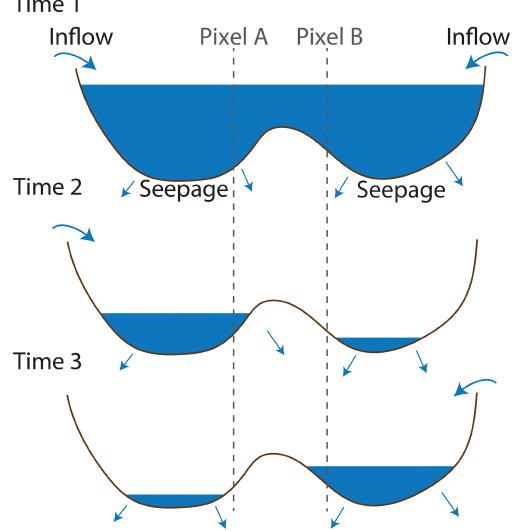
Figure 7. Violation of the homogeneity assumption in a fragment- ing lake. A single body of water (top) might fragment into indepen- dent fragments when draining (middle and bottom). In the figure, the lake is drained by seepage, and the two fragments are supplied by distinct tributaries. Under these conditions, pixels A and B might have an identical IF value but do not have an identical flooding sta- tus at times 2 and 3 and, hence, violate the homogeneity